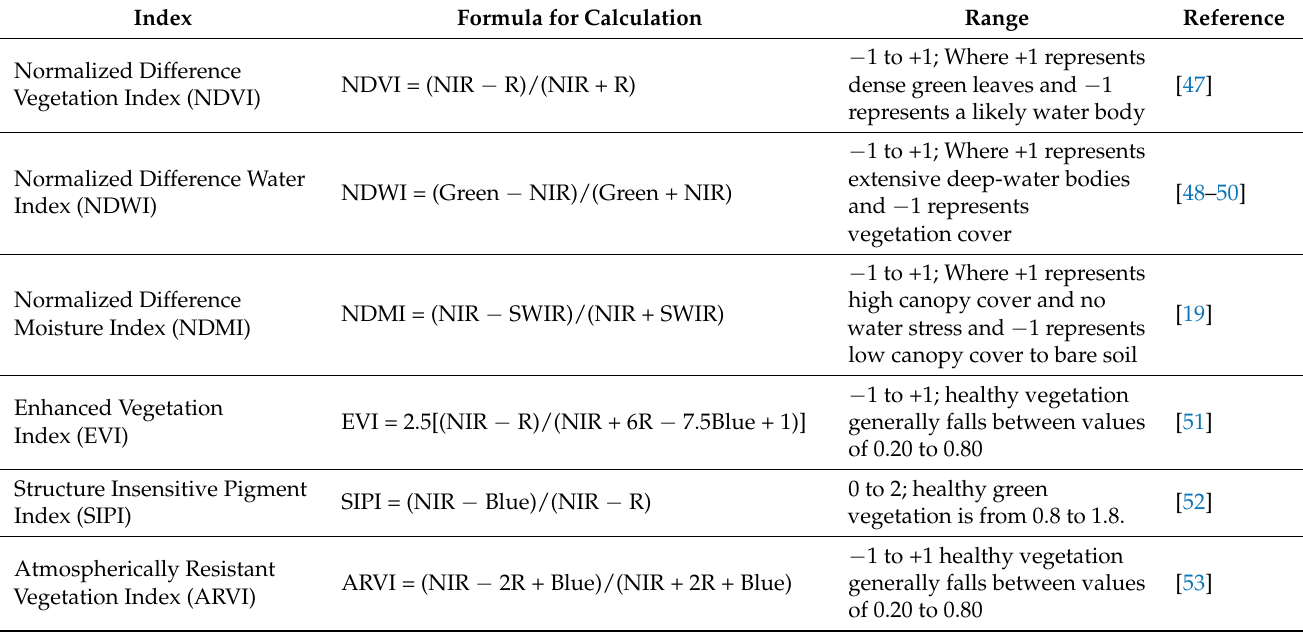
Table 2. List of moisture-related indices along with formula used to calculate, and their range for Landsat 8 satellite images used in this